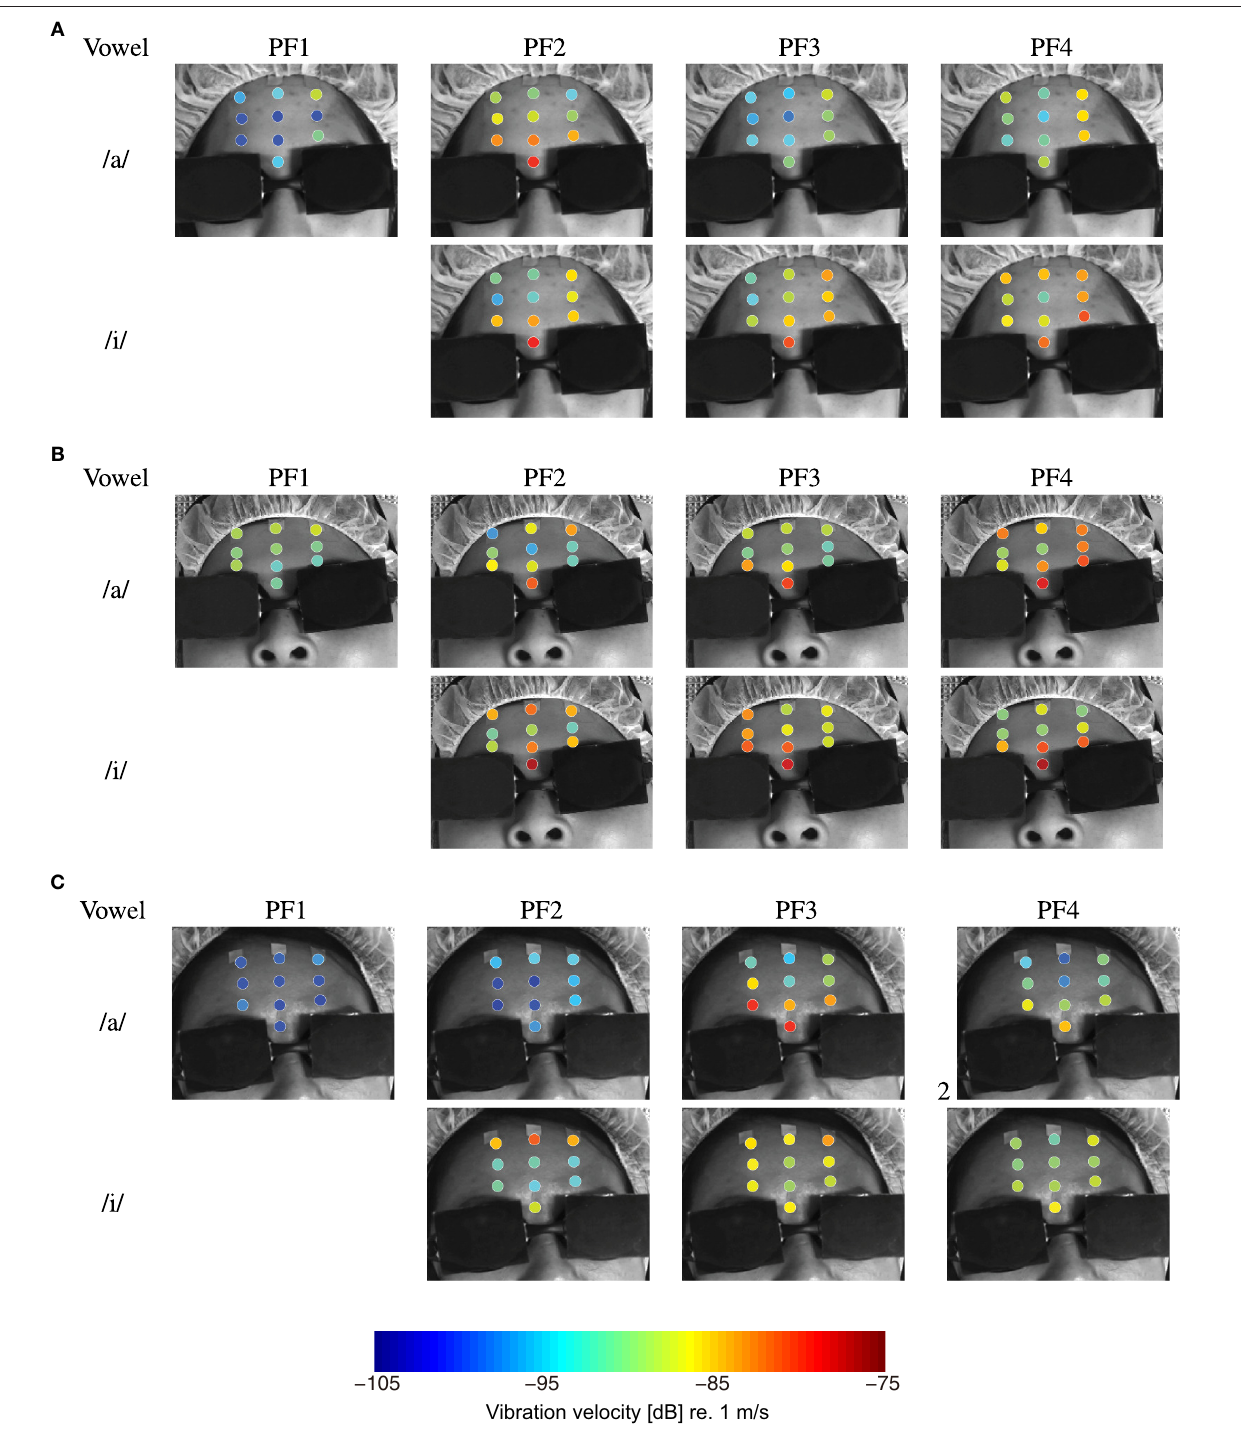
FIGURE 6 | Forehead surface vibration velocities of three singers while singing Japanese vowels /a/ and /i/ for four pitch frequencies, PF1, PF2, PF3, and PF4. Velocities are given in m/s (dB), where 0dB is equivalent to 1m/s. Singer (A) , Singer (B) , and Singer (C) .